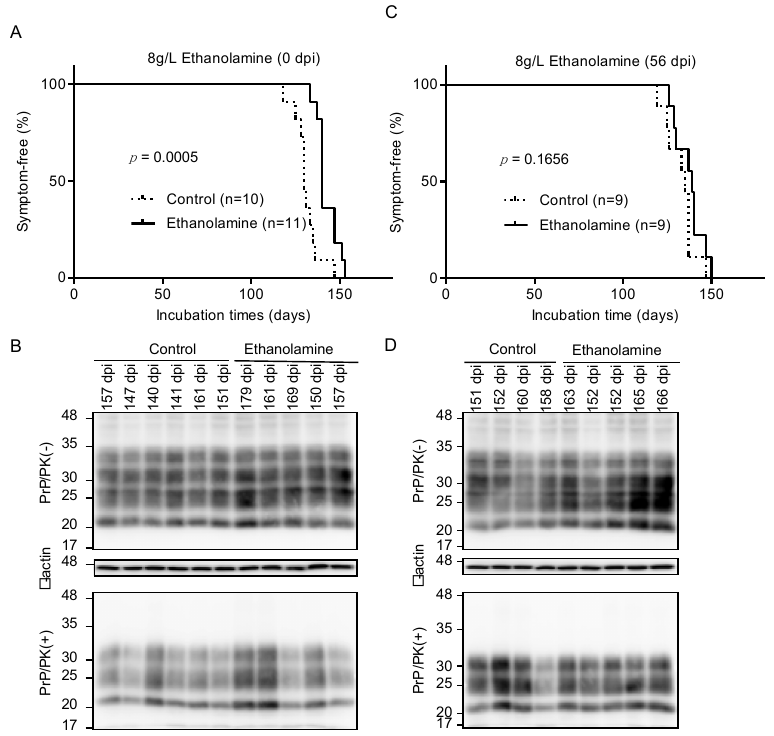
Figure 3. Ethanolamine delays prion disease in prion-infected mice. ( A ) Percentage of symptom- free mice intracerebrally inoculated with RML prions after oral administration with or without eth- anolamine through drinking water starting from the inoculation day. ( B ) Western blotting with 6D11 anti-PrP antibody of PK-treated or -untreated brain homogenates from the control ( n = 6) and